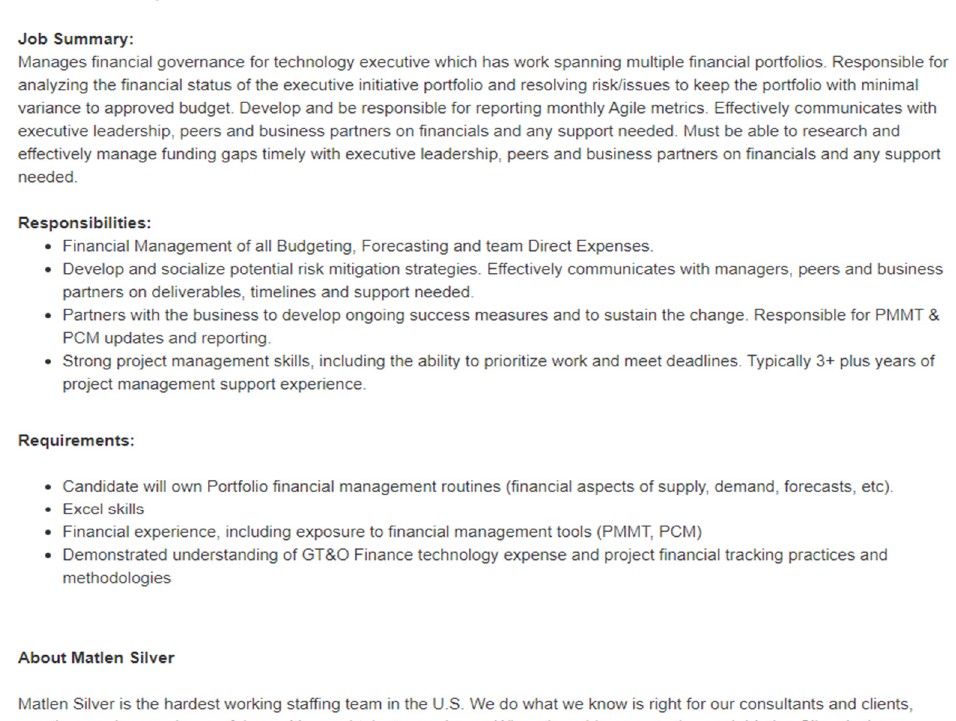
Figure 1. Example of a job advertisement on the job portal dice.com (20 March 2021). Figure 1.